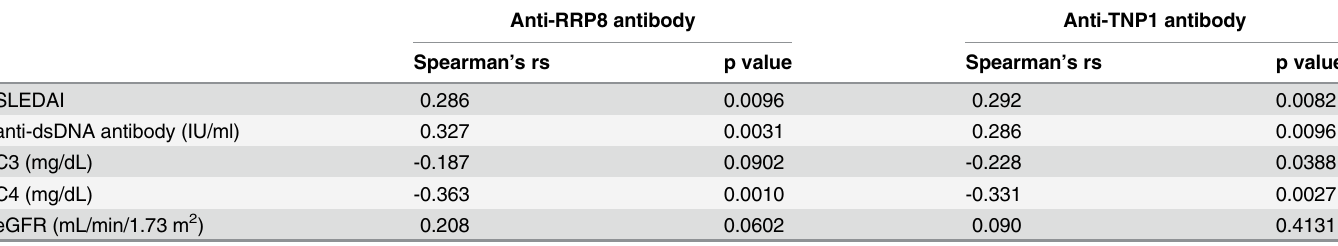
Table 3. Correlation between anti-RRP8 or anti-TNP1 antibody level and clinical findings in SLE patients.